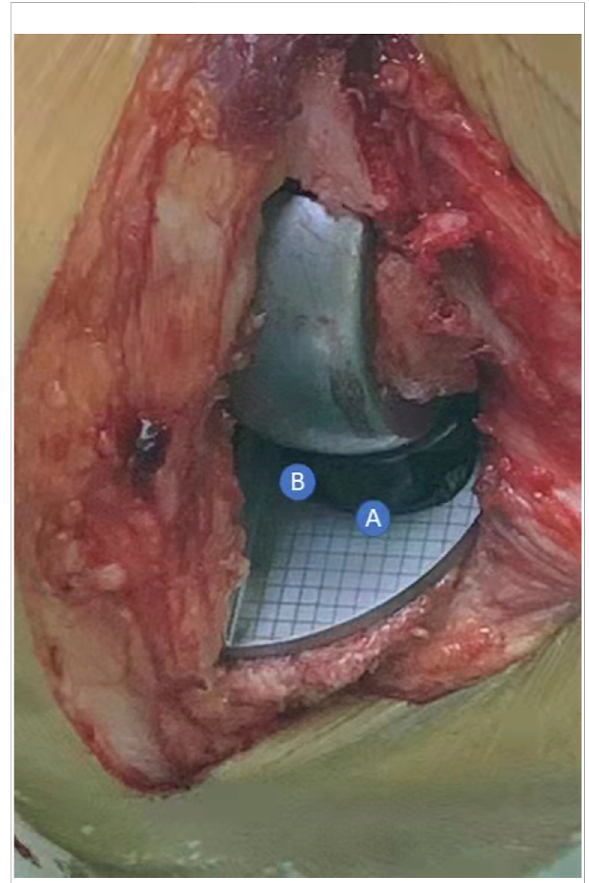
FIGURE 2 In 90 ° knee fl exion, recording the coordinate of the anterior corner (A point) and anterolateral corner (B point) as the location of the meniscus bearing. The location of the meniscus bearing in other angles (90 ° , 60 ° , 45 ° , 30 ° , 20 ° , and 0 ° ) was recorded in the same way and fi nally formed the movement trajectory.